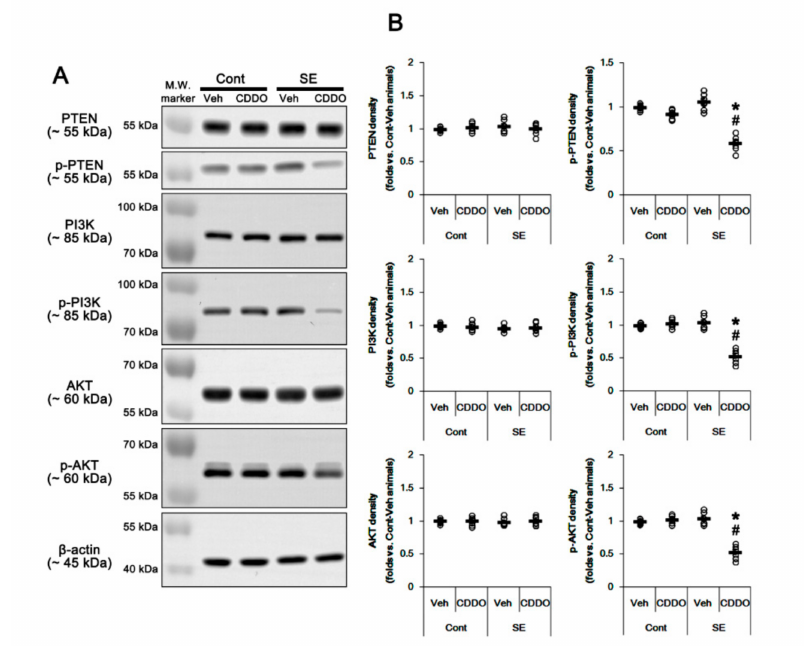
Figure 3. E ff ects of CDDO-Me on activities (phosphorylations) of PTEN, PI3K, and AKT following SE. PTEN, PI3K, and AKT expressions and their phosphorylations are una ff ected by SE. CDDO-Me reduces PTEN, PI3K, and AKT phosphorylations without changing their expression levels under the post-SE condition. ( A ) Representative Western blots of PTEN, PI3K, and AKT expressions and their phosphorylations. ( B ) Quantification of PTEN, PI3K, and AKT expressions and their phosphorylations based on Western blot data. Open circles indicate each individual value. Horizontal and vertical bars indicate mean value and S.E.M., respectively (mean ± S.E.M.; *,# p < 0.05 vs. control animals and vehicle, respectively, one-way ANOVA followed by Newman-Keuls post hoc test; n = 7,